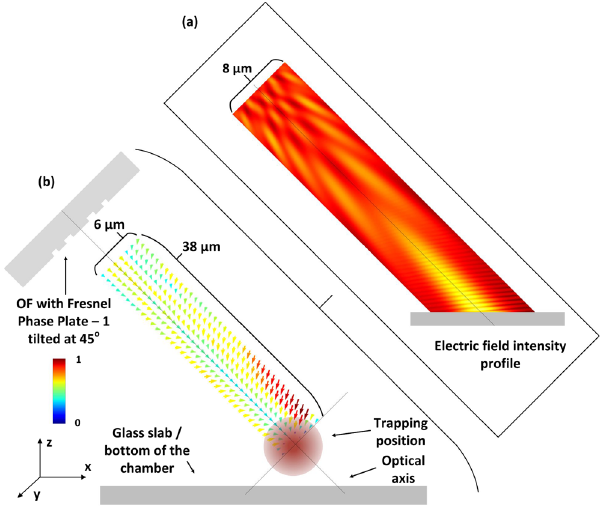
Figure 8. ( a ) Field intensity profile for FPP-1 tilted at 45° immersed in water; ( b ) corresponding force distribution map, for the particular case of 8 µ m PMMA